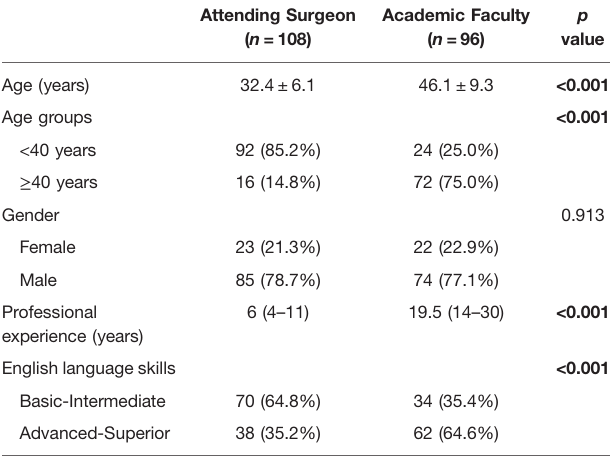
TABLE 3 | Demographic characteristics of the participants according to their appointment